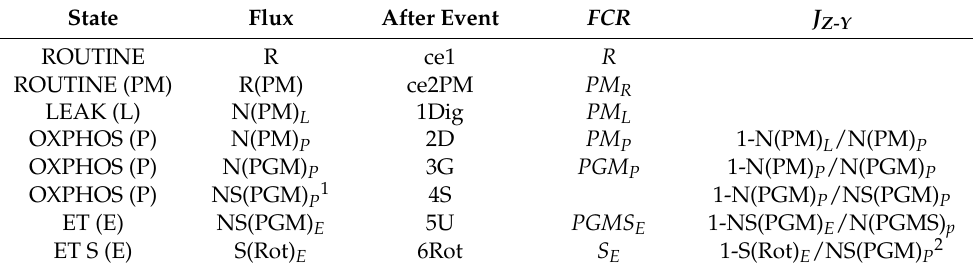
Table 5. Respiratory states, flux control ratios, and flux control efficiency,